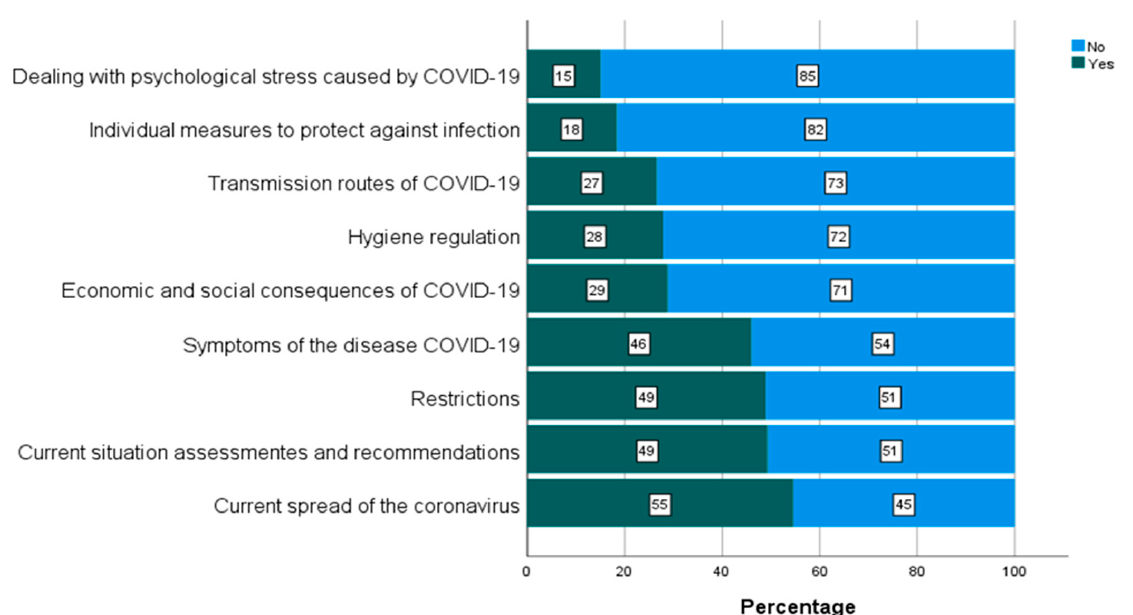
Figure 3 . Internet search queries related to COVID-19. (N=1518). Pct.